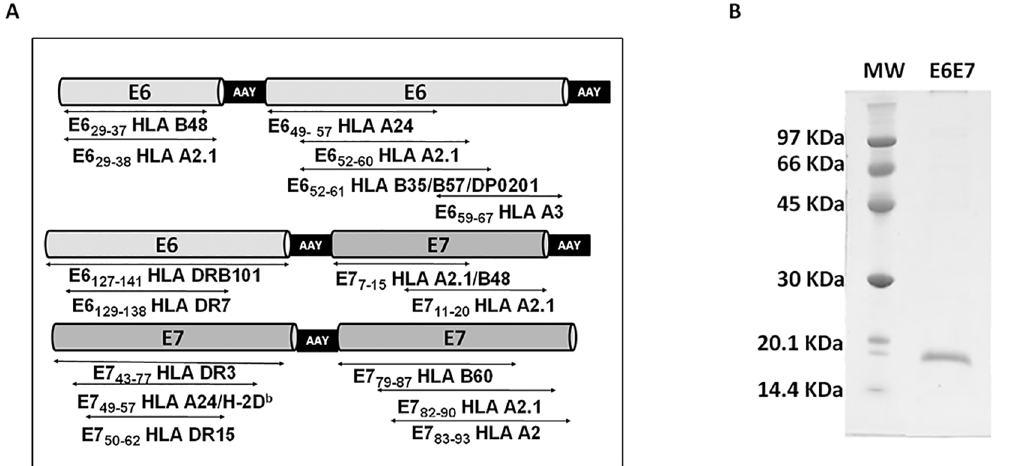
Fig 1. Design and purification of the vaccine antigen. (A) Scheme of the designed E6E7 antigen. Ala-Ala-Tyr (AAY) spacers were inserted between the epitopes. (B) SDS-PAGE of purified antigen stained with Coomassie Brilliant Blue. MW: molecular mass marker.